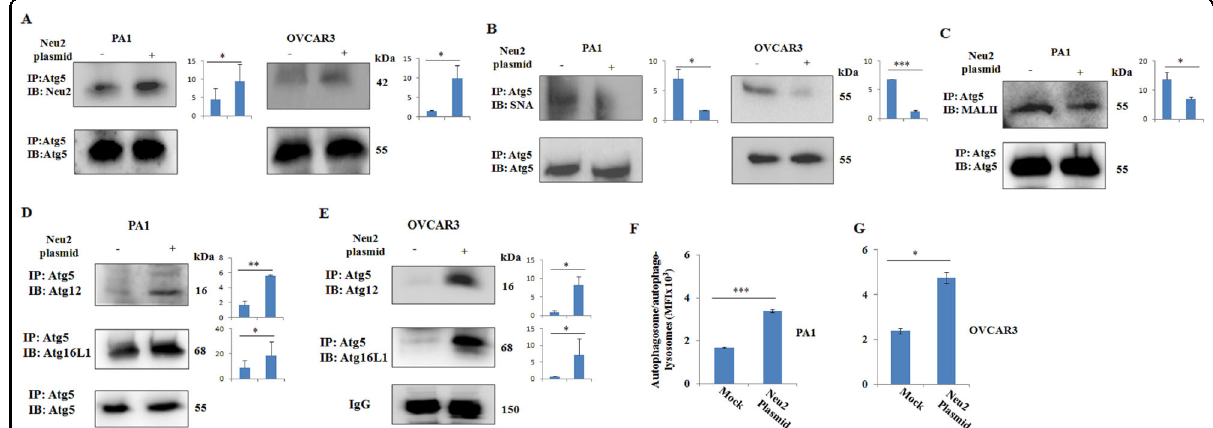
Fig. 3 Linkage-speci fi c desialylation of Atg5 by overexpressed Neu2 leads to enhanced autophagosome formation in OC cells. A Co- immunoprecipitation analysis showing the enhanced association of Atg5 with Neu2 in overexpressed conditions as compared to mock in both PA1 and OVCAR3 cells. Atg5 acts as a loading control. B , C Neu2 overexpression induced decreased binding of Atg5 with SNA in OC cells ( B ) and MALII in PA1 cells ( C ). Atg5 acts as a loading control. D , E Co-immunoprecipitation showing the increased association of Atg5 with Atg12 and Atg5 with Atg16L1 in Neu2-overexpressed PA1 and OVCAR3 compared to mock. Atg5 band and IgG band acts as the loading control in PA1 and OVCAR3, respectively. F , G Neu2-transfected PA1 ( F ) and OVCAR3 ( G ) cells showed enhanced autophagosomes/autophagolysosomes compared to mock as analyzed using speci fi c green fl uorescent dye by fl ow cytometry. The mean fl uorescence index (MFI) is plotted on the bar graph for comparison. The results are represented as mean ± SD from independent experiments and p values (* p < 0.05; ** p < 0.01; *** p < 0.001; two-tailed t test) represented the signi fi cant differences between the means of the two test